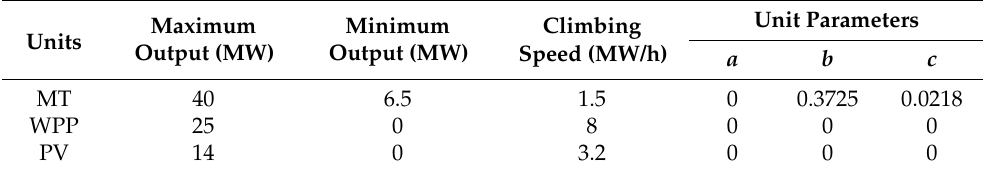
Table 1. Units’ generation parameters setting.